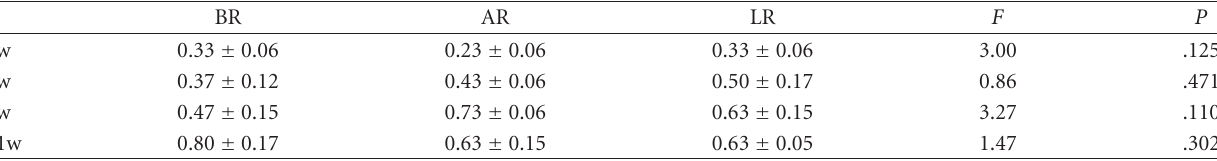
Table 2: The express level of the OX62 + intestinal DC of each group in di ff erent development stage (Mean ± S) ( N = 5). BR AR LR F P 3w 0.33 ± 0.06